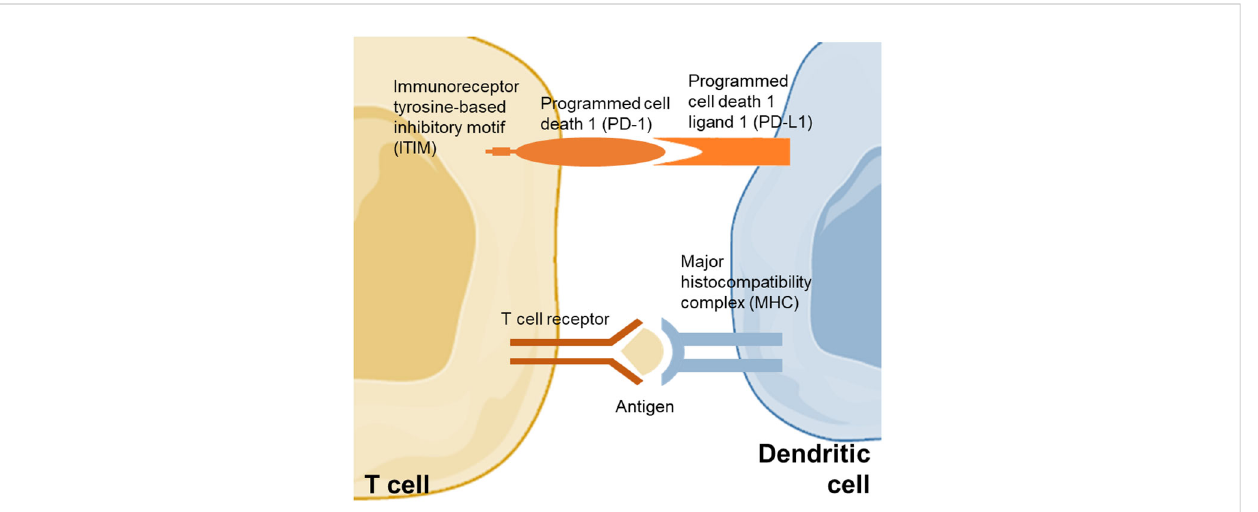
FIGURE 1 PD-1 and PD-L1 between dendritic cell and T cell. PD-1 pathway activation is modulated by the binding of Src homology domain-containing protein tyrosine phosphatase 1 and 2 to immunoreceptor tyrosine-based inhibitory motif that repress the proliferation of T cell. The pathway modulates inhibitory signals for the activation of T